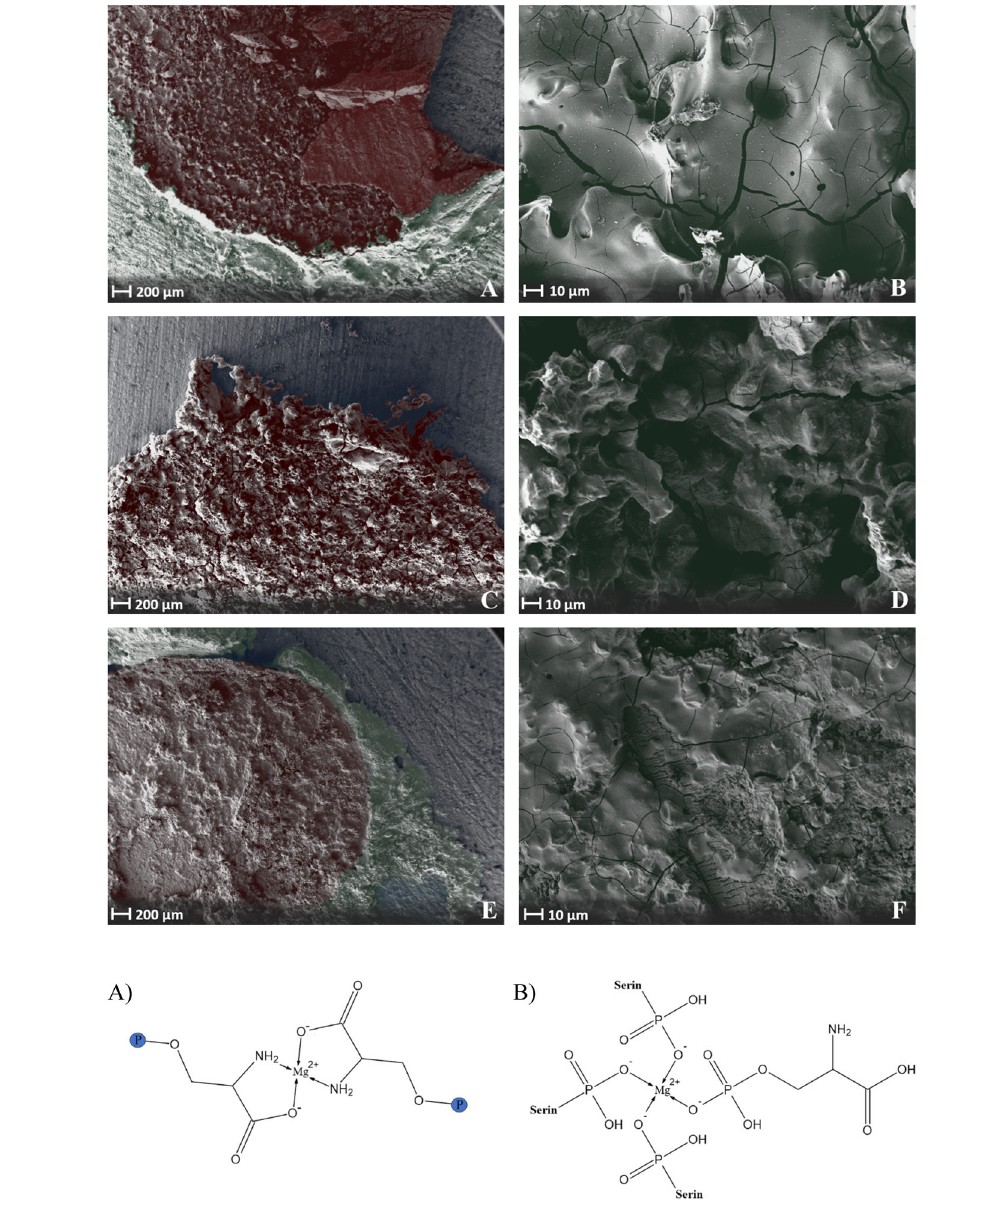
Fig. 8 Scanning electron micrographs of an adhesive joint on hydroxyapatite specimen made of: Composition (1) (OPLS/ MgO(291)/ Mg 3 (PO 4 ) 2 / H 2 O) at 25x ( A ) and ×500 ( B ) magni fi cation on a HA specimen after failure in the shear test. Composition (3) (OPLS/ Mg 3 O 8 P 2 ∙ xH 2 O(heat treated)/ H 2 O) at 25x ( C ) and ×500 ( D ) magni fi cation. Reference (OPLS/ TTCP H 2 O) at ×25 ( E ) and ×500 ( F ) magni fi cation. The raw images were stained by computer graphics for better orientation: Red: Sheared off adhesive joint. Green: Supernatant of the adhesive joint without mechanical testing.